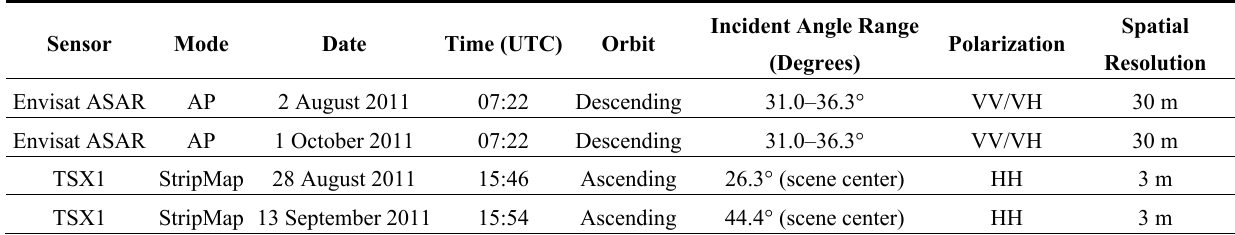
Table 4. SAR images. TSX1,